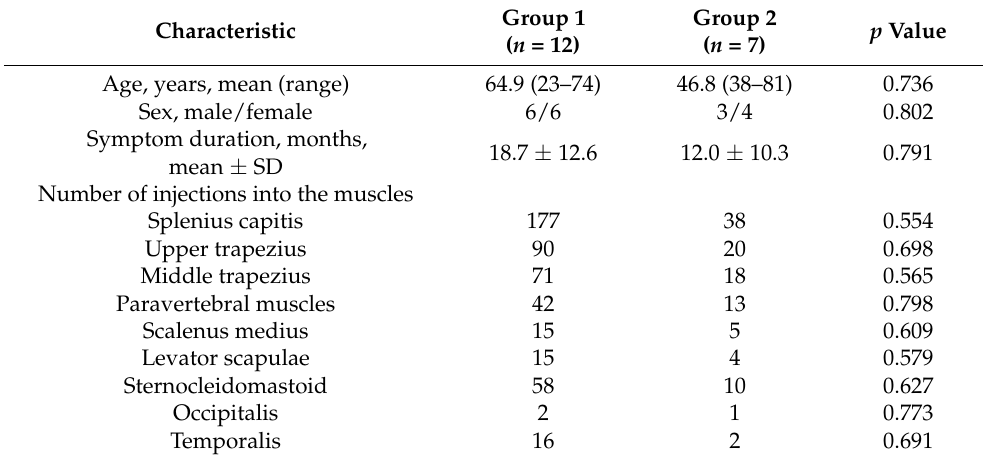
Table 1. Comparison of demographic and clinical characteristics of the patients.